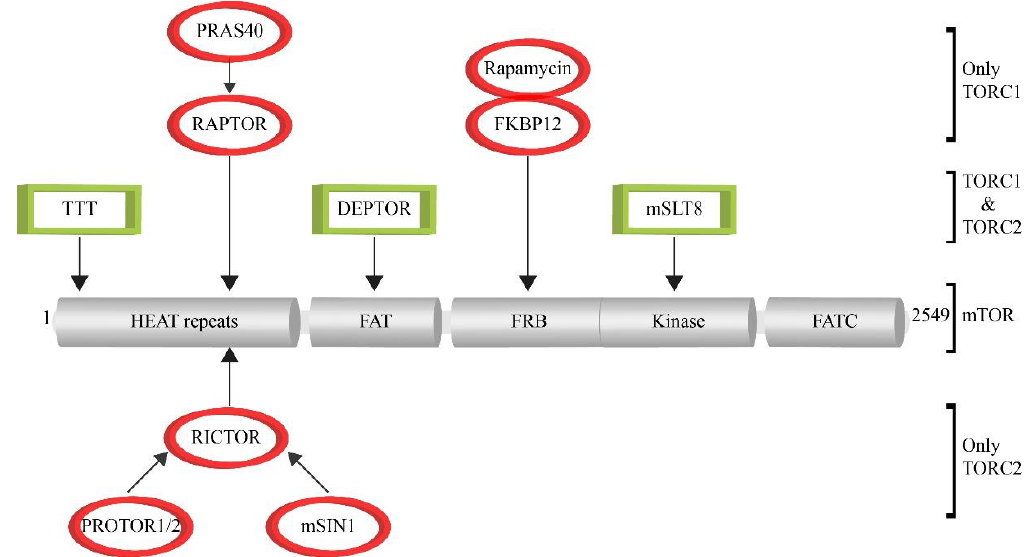
Figure 2. Composition of mTOR-complexes. The functional domains of the mTOR protein are depicted in the center. The binding factors present in both TORC1 and TORC2 are shown in boxes (TTT, DEPTOR, mLST8). The TORC1-specific factors are shown in ovals on top of the figure (RAPTOR, PRAS40, FKBP12-rapamycin), while the TORC2-specific factors are shown at the bottom (RICTOR, PROTOR1/2, mSIN1).